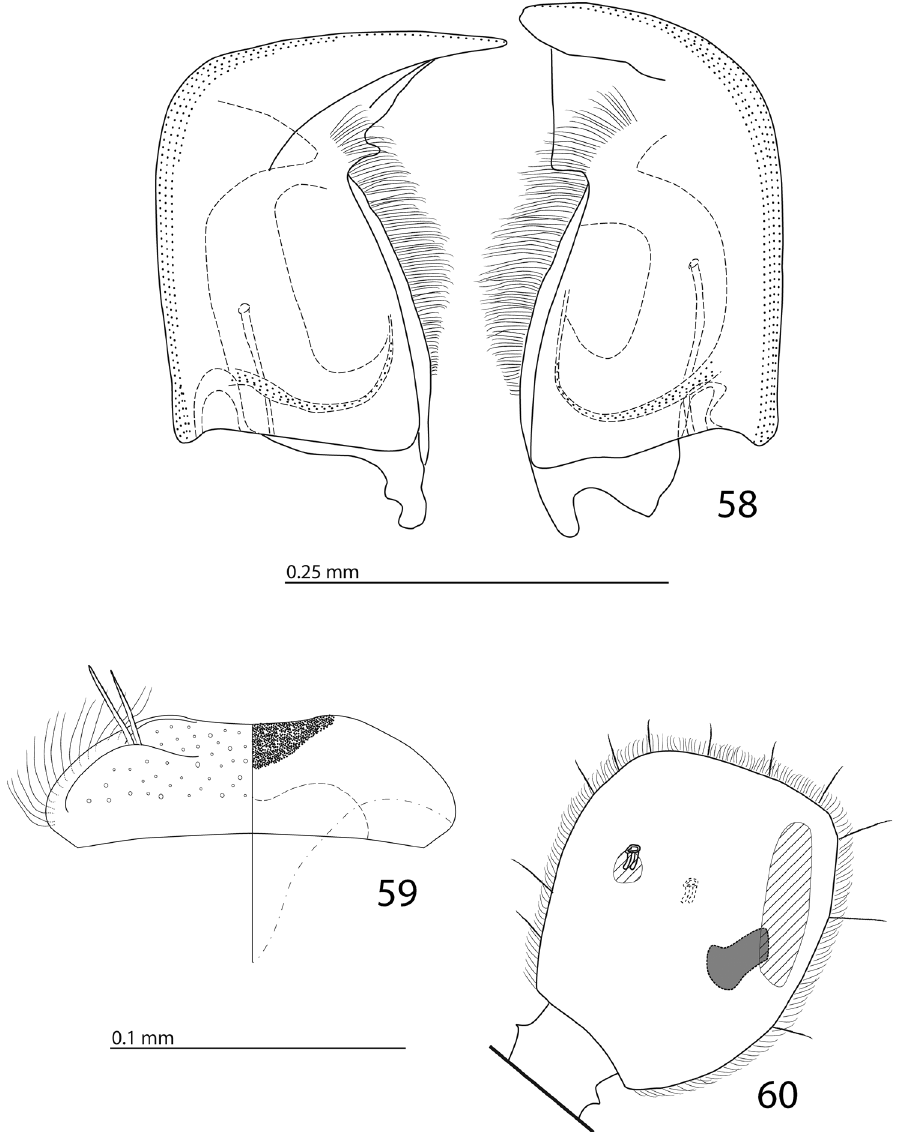
Figures 58–60. 58 Euspilotus ( Neosaprinus ) rubriculus (Marseul, 1855) mandibles, dorsal view 59 labrum: left half depicting dorsal view and right half depicting epipharynx 60 antennal club, ventral view showing sensory structures of the